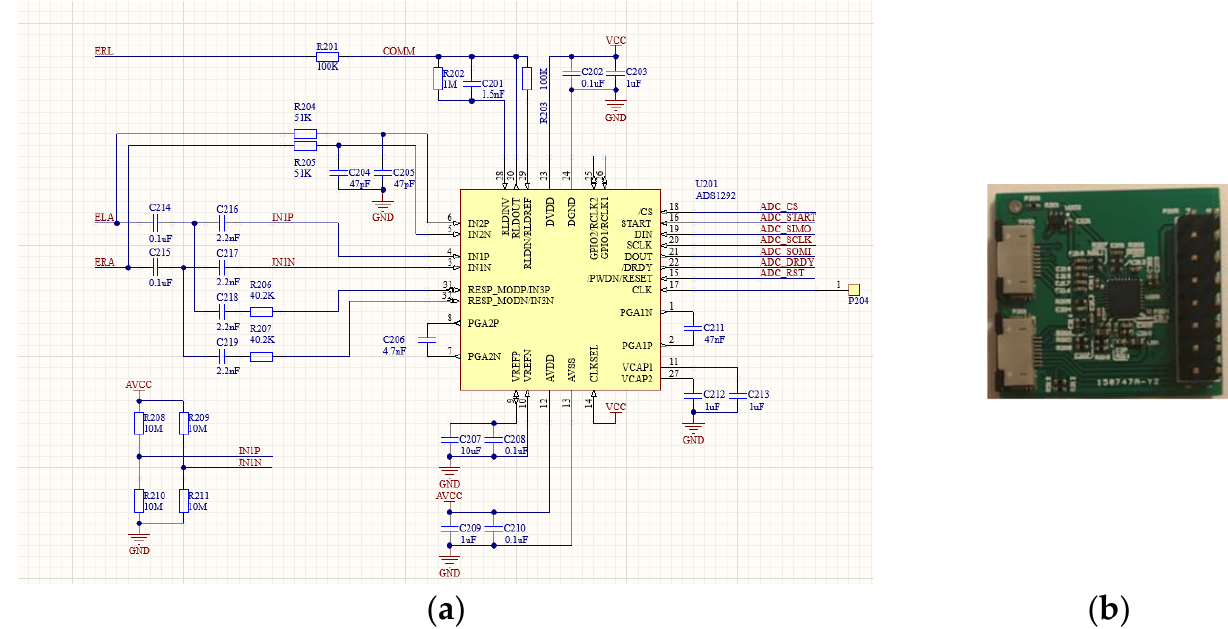
Figure 4. The analog front-end (AFE) circuit board: ( a ) schematic diagram; ( b ) circuit board.